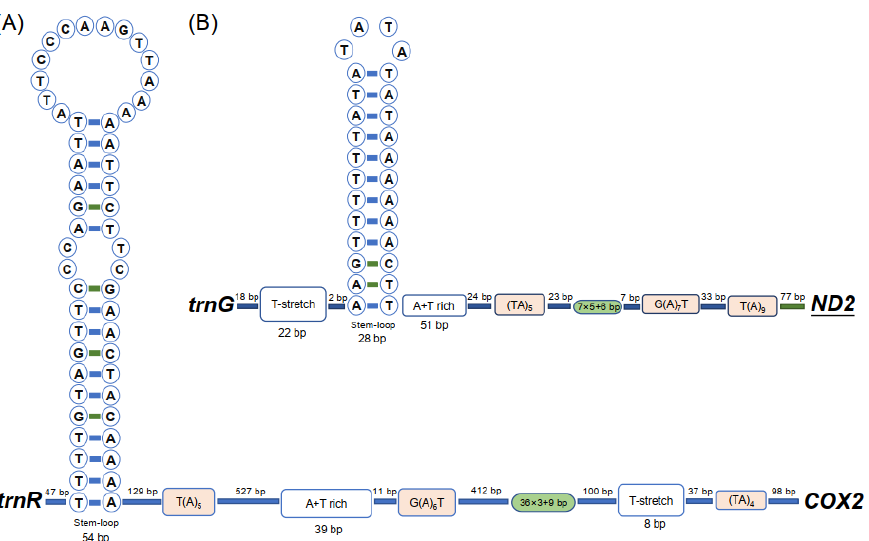
Figure 2. The secondary structure of the two putative control regions of Aeolothrips xinjiangensis . ( A ) Control region 1. ( B ) Control region 2. The bases are displayed from left to right following the gene orientation 5′ to 3′. Boxes indicate the motifs; oval frames represent tandem repeats. The 148 bp non-coding nucleotides are located between ND4 and ND4L in the mi- togenome of Aeolothrips xinjiangensis . In other thrip mitogenomes, 10 species have 1–21 bp overlaps (most were 7 bp) between ND4 and ND4L , and three species have 5–18 bp non- coding nucleotides (Table S3). In the mitogenomes of insects, ND4–ND4L was